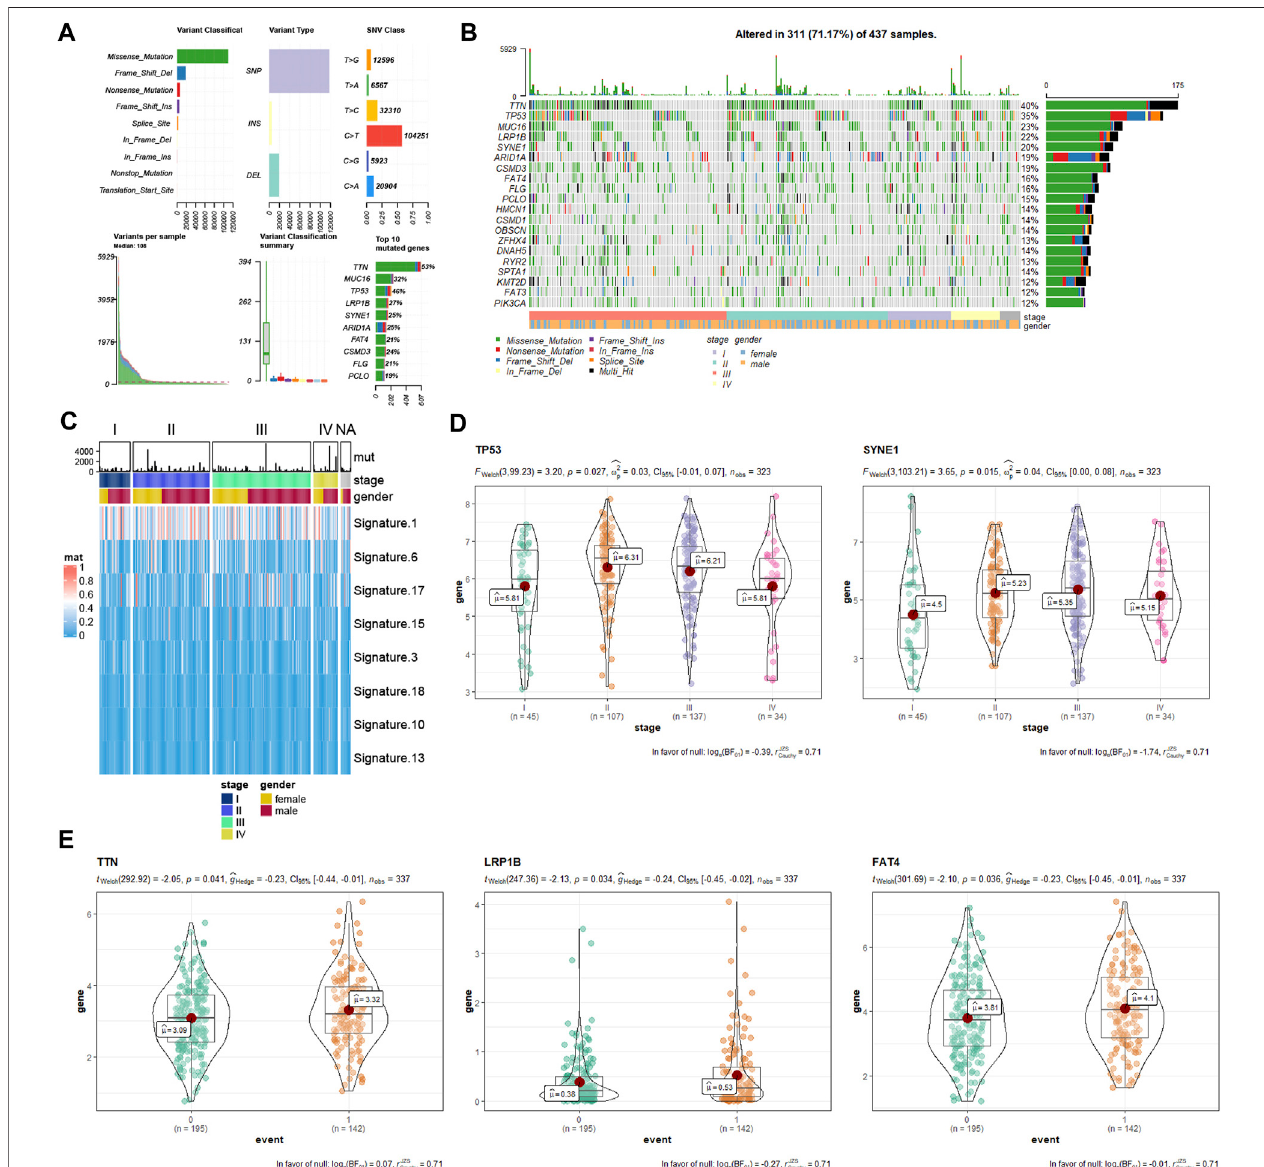
FIGURE6| GenemutationinformationofGCsamplesfromTCGAdatabase. (A) mutationpro fi lelandscapeinGCsamples. (B) waterfallplotshowingthemutation details of every gene in every sample. (C) heatmap showing the signi fi cant signatures of mutated genes. (D) correlation analysis between tumor stage with mutated genes(TP53andSYNE1). (E) correlationanalysisbetweensurvivalevent(0,alive;1,death)withmutatedgenes(TTN,LRP1B,andFAT4).GC,gastriccancer;TCGA,The Cancer Genome Atlas.